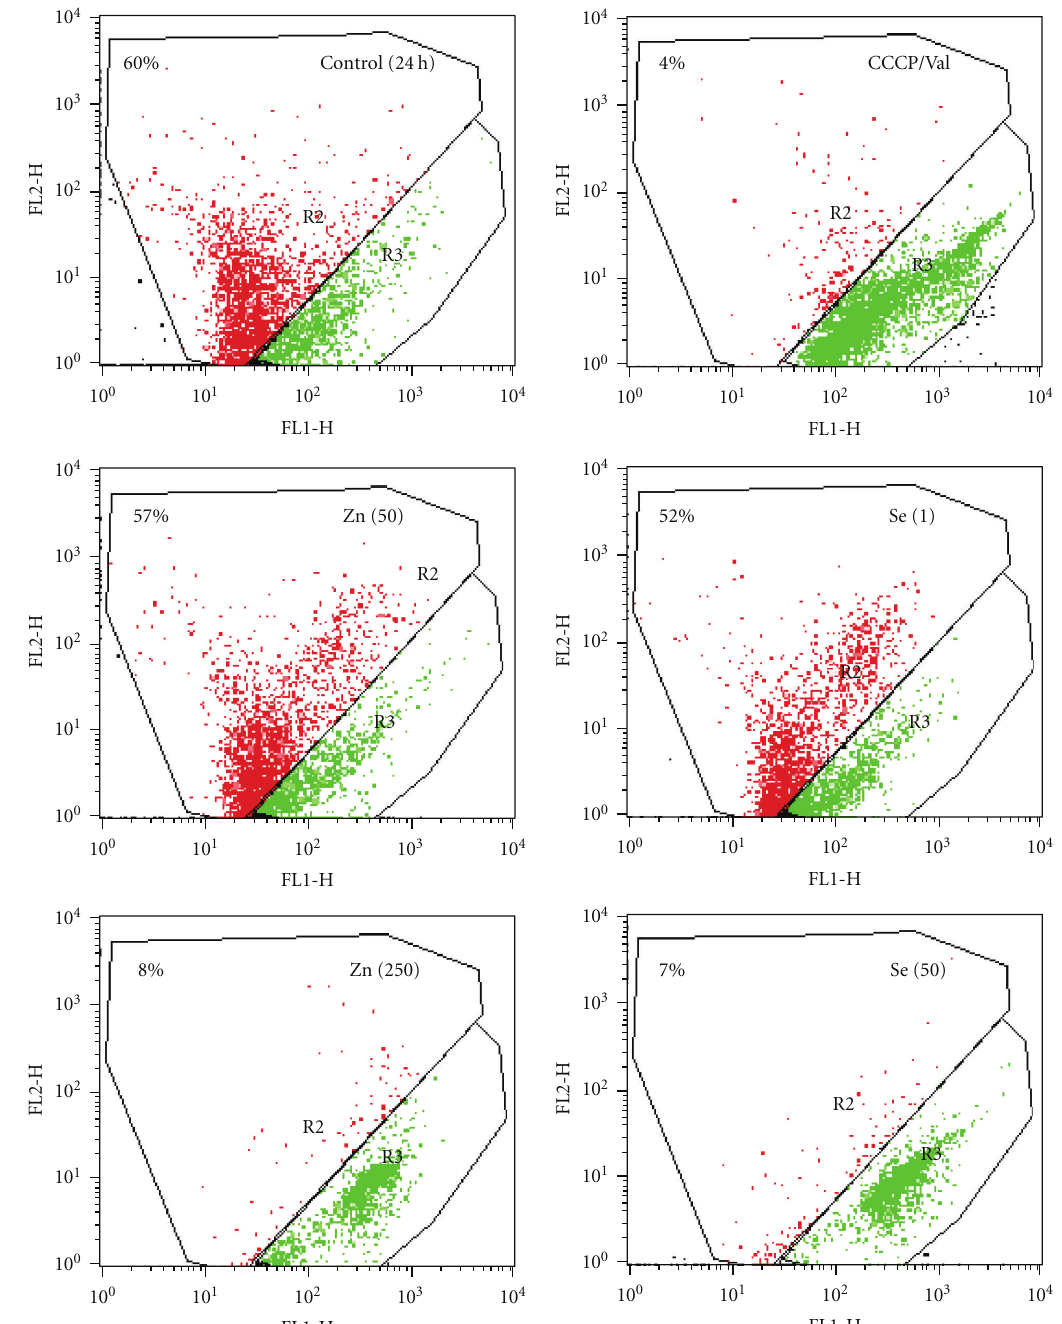
Figure 3: Action of di ff erent concentrations of Zn 2+ and selenite on the mitochondrial transmembrane potential after 24h incubation with AS-30D cells. JC-1 is a cell-penetrating dye that accumulates within mitochondria maintaining high ΔΨ mito and changes its emission fluorescence from green to red that can be followed by flow cytometry. The percentage of cells with red (R2) and green (R3) JC-1 fluorescence, reflecting high and low ΔΨ mito , respectively, was estimated; R2 is indicated in the upper left corner of each panel. The protonophoric uncoupler CCCP plus the potassium ionophore valinomycin, acting together to completely collapse ΔΨ mito , have always been used as the “positive” control. A typical experiment out of at least three independent ones is